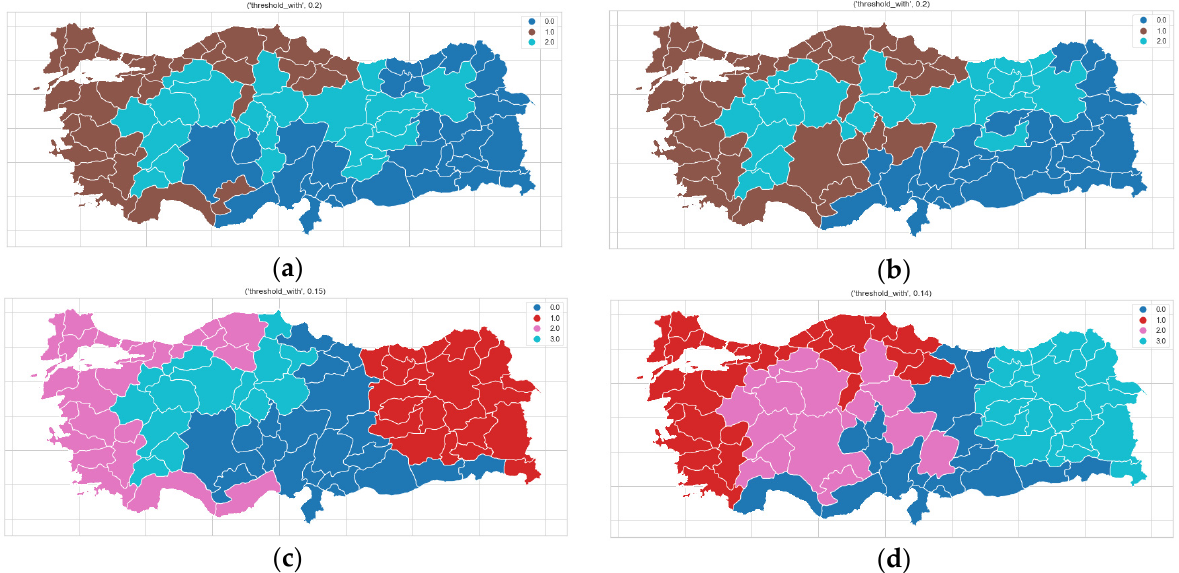
Figure 6. Spatially constrained clustering results, ( a ) Queen neighboring-3 clusters, ( b ) Rook neighboring-3 clusters, ( c ) Queen neighboring-4 clusters, and ( d ) Rook neighboring-4 clusters.